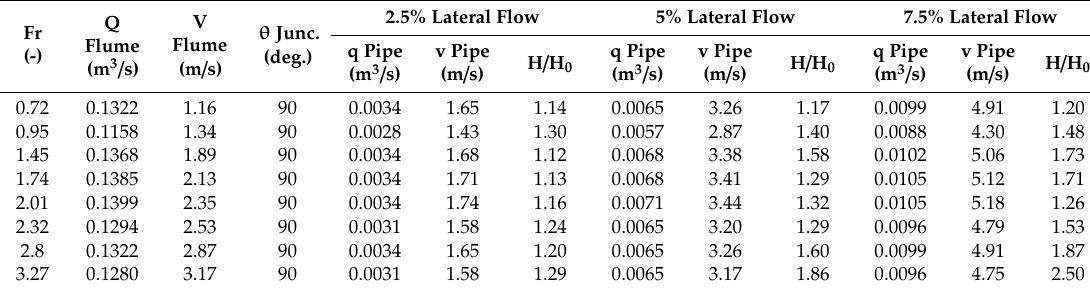
Table 4. Experimental results for the 90 ◦ junction in the narrow channel.